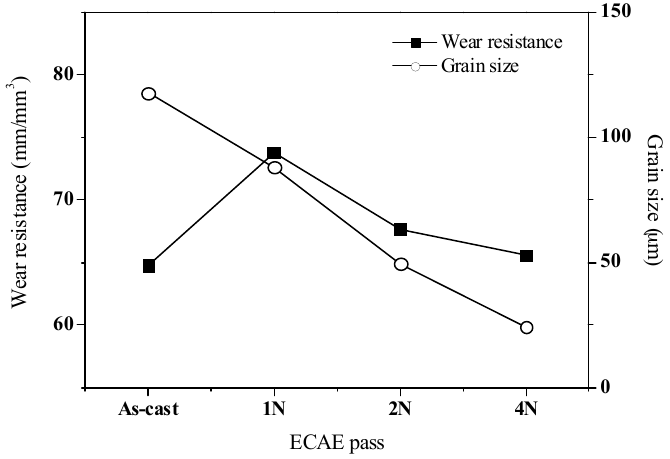
Figure 4. The wear resistance of the as-cast and ECAE-processed Mg-Sn alloys. Table 1. EDS results obtained from the as-cast and four-pass ECAE-processed alloys.